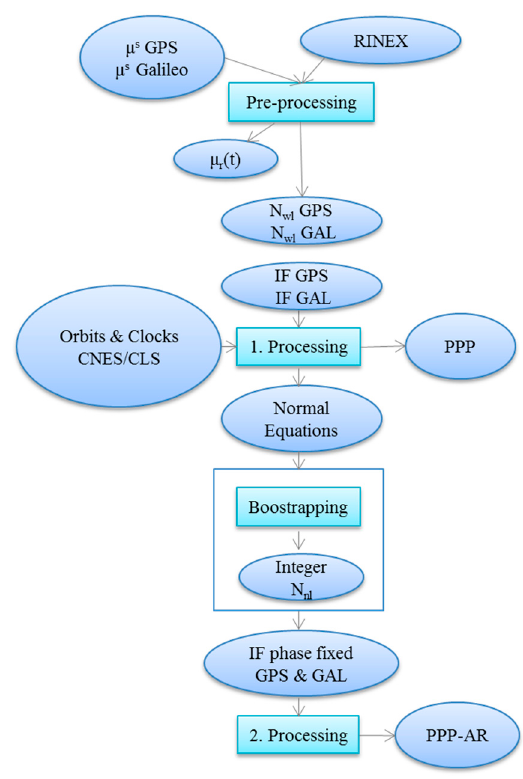
Figure 1. Steps of the procedure to perform precise point positioning (PPP) and PPP with phase ambiguity resolution (PPP-AR) of a combined Multi-GNSS solution (GPS + Galileo).